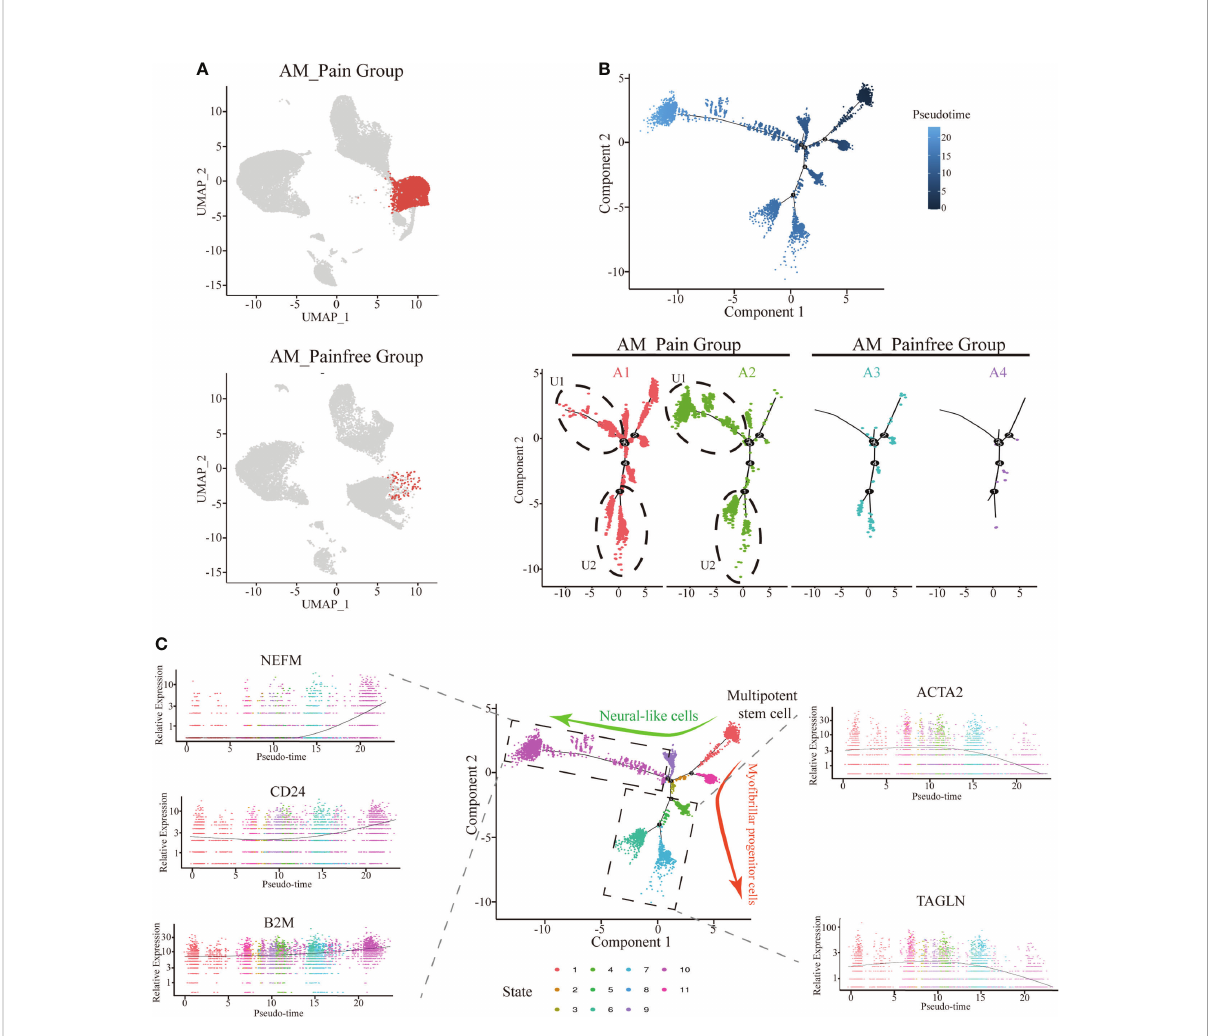
FIGURE 3 Differentiation of multipotent stem cells into neural-like cells in the single-cell trajectory analysis. (A) Comparison of cluster 3 and 13 cell numbers between AM_Painfree and AM_Pain groups. (B) Multipotent stem cells differentiated into two main cell populations in the AM_Pain group with the pseudotimeline, U1 and U2. (C) The U1 region cells mainly expressed nerve-associated markers, NEFM, CD24, and B2M, while the U2 region cells primarily expressed smooth muscle cell – associated markers, ACTA2 and